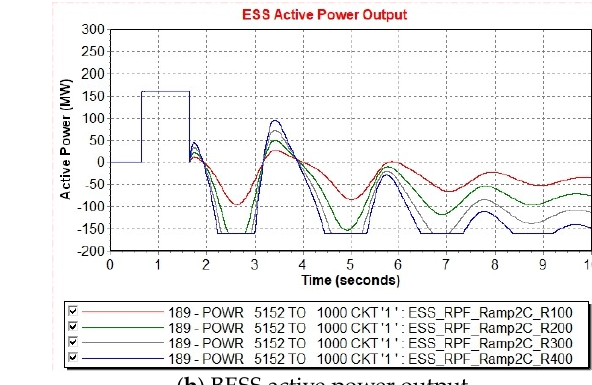
Figure 10. Performance of a frequency response BESS by varying the droop gain.